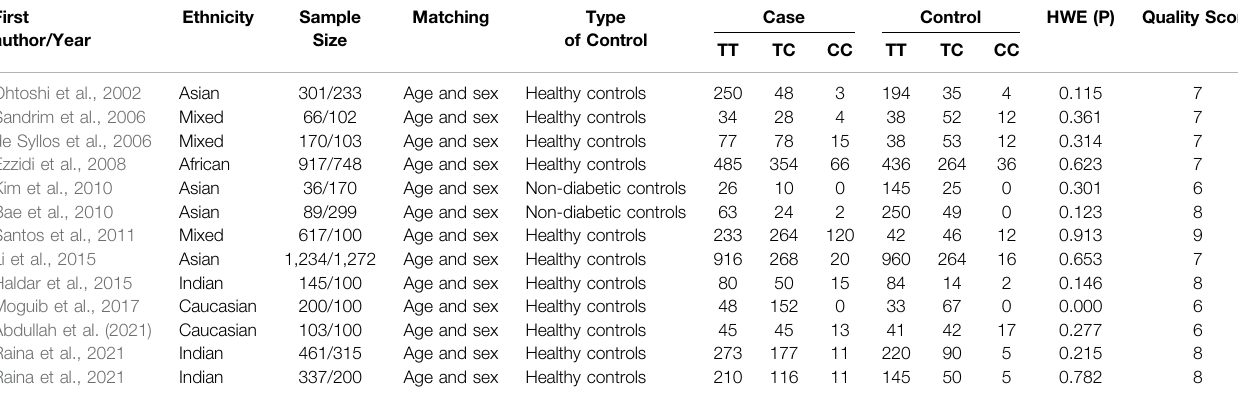
TABLE 4 | Genotype distribution of eNOS T786C polymorphisms in the included studies of